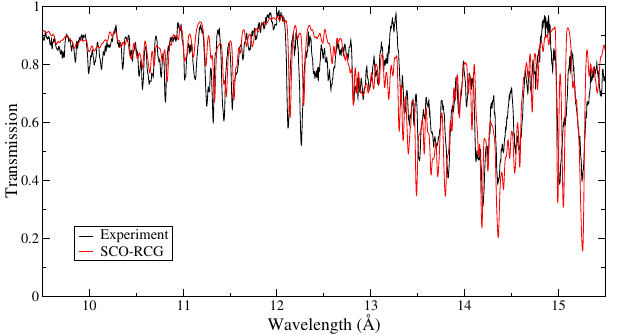
Figure 5. Iron transmission spectrum measured by Bailey et al. [33] on the SNL Z facility. Comparison between experiment and our SCO-RCG calculation at T = 150 eV and ρ = 0.058 g/cm 3 . The areal mass, measured by Rutherford backscattering, is equal to 54 µ g/cm 2